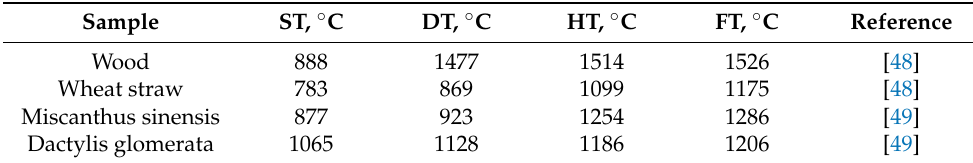
Figure 5. Ash melting temperatures of plant waste pellets (proportions of potato and beans: 1:1 (A); 1:2 (B); 1:3 (C); 1:4 (D) by volume). Table 6. Ash melting temperatures of plant and wood